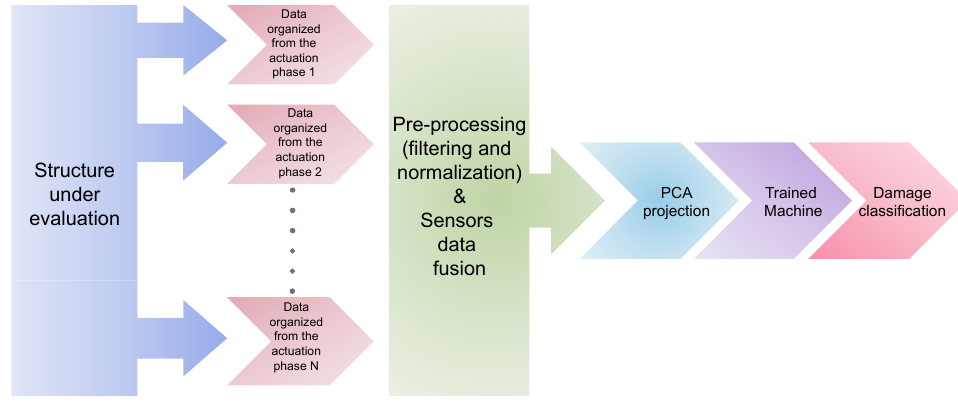
Figure 9. Classification methodology